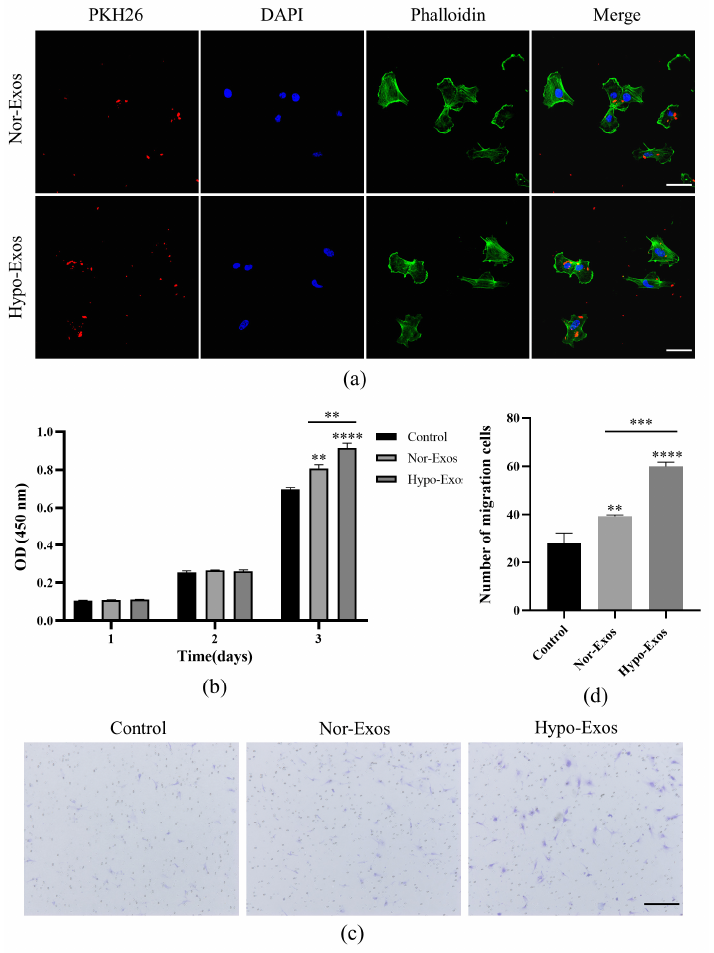
Figure 3. Effects of Nor-Exos and Hypo-Exos (10 µ g/mL) on HUVEC proliferation and migration. ( a ) Fluorescence microscopy analysis of PKH26-labelled exosomes (red) internalized by HUVECs. The cytoskeleton was stained by phalloidin (green) and nuclei were stained with DAPI (blue). ( b ) The proliferation of HUVECs was assessed by CCK-8 assay. ( c ) The migration of HUVECs was evaluated by transwell assays. ( d ) Quantitative analysis of the migrated cells in ( c ). n = 3, mean ± SD, ** p < 0.01, *** p < 0.001, **** p < 0.0001. Scale bars: 50 μ m ( a ); 200 μ m ( c ).